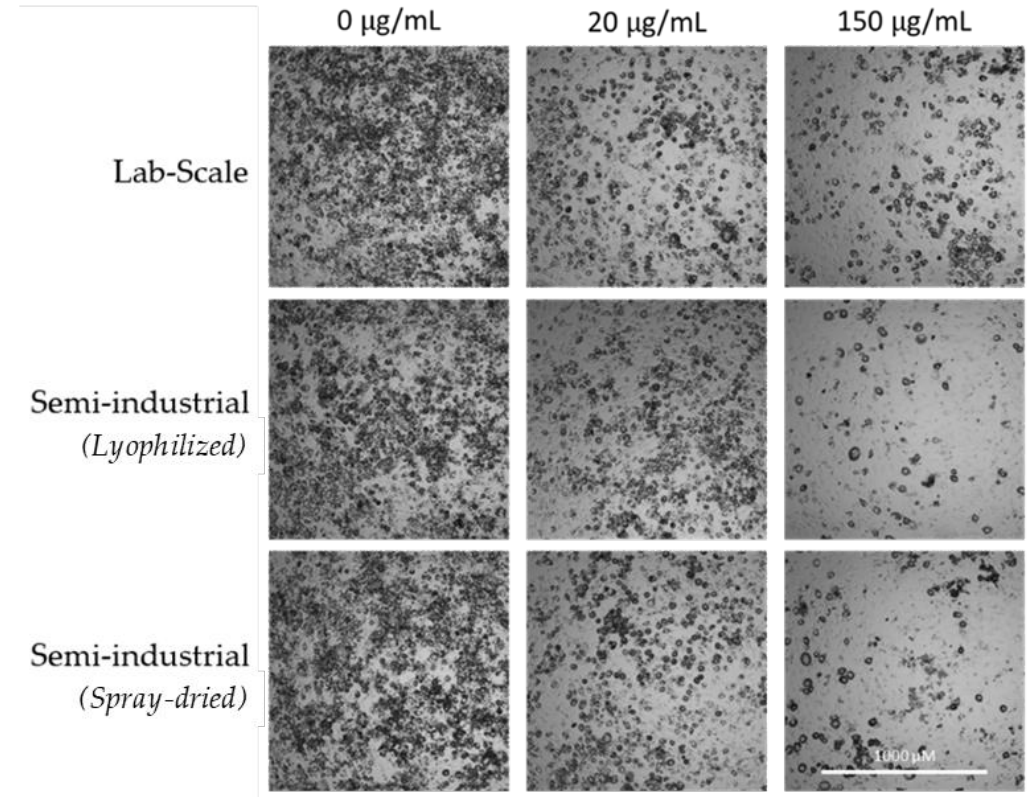
Figure 9. Representative microscope images of 3t3-L1 cells treated with different concentrations of the three tested extracts showing the accumulation of lipid droplets.